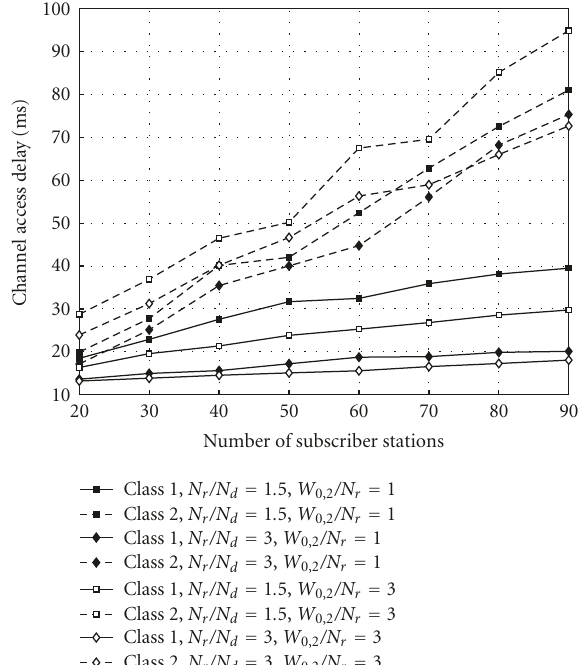
Figure 11: Channel access delay versus number of SSs with absolute bandwidth allocation priority, and di ff erentiated channel access parameters: W 0,1 = W 0,2 = N r , W x ,1 = 2 4 W 0,1 , and W x ,2 = 2 8 W 0,2